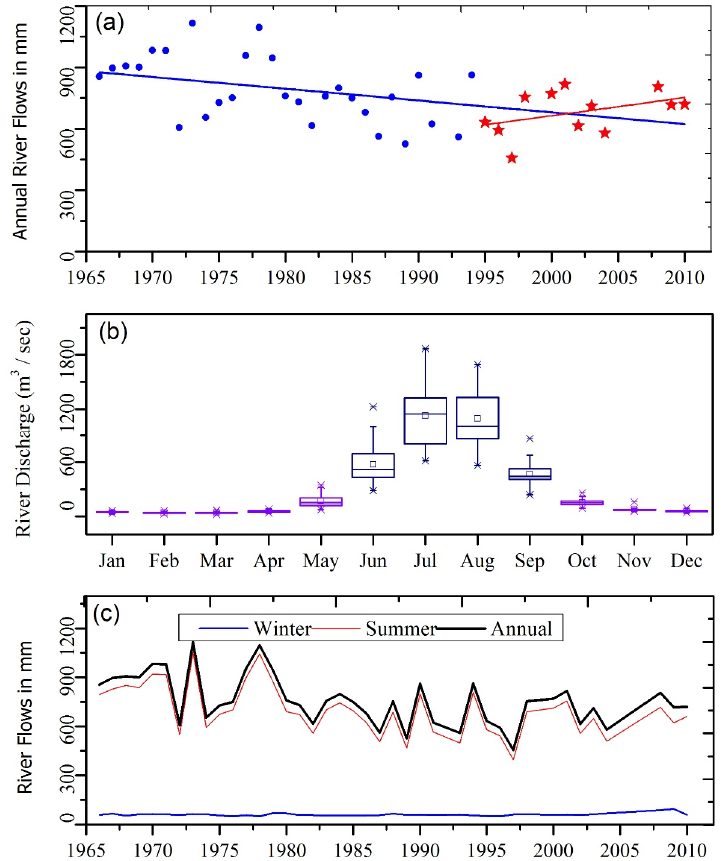
Figure 8. ( a ) Annual river flows during 1966 and 2010 (stars indicate annual flows during 1995 and 2010 only) with linear trends. ( b ) Box plot of monthly flows during 1966 and 2010, dominated by flows in July and August followed by June and September. ( c ) Winter flows were very low, whereas summer and annual flows followed the same pattern which means annual flows are governed by summer flows.